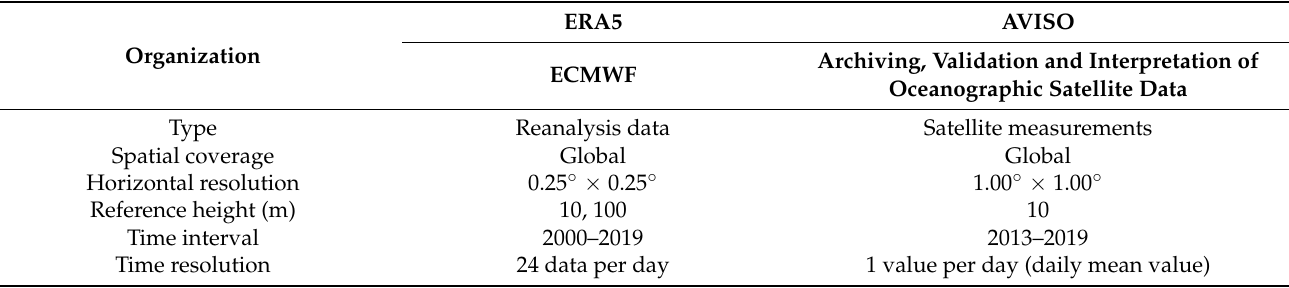
Table 1. Characteristics of the datasets processed for assessing the wind conditions in the Romanian coastal area.